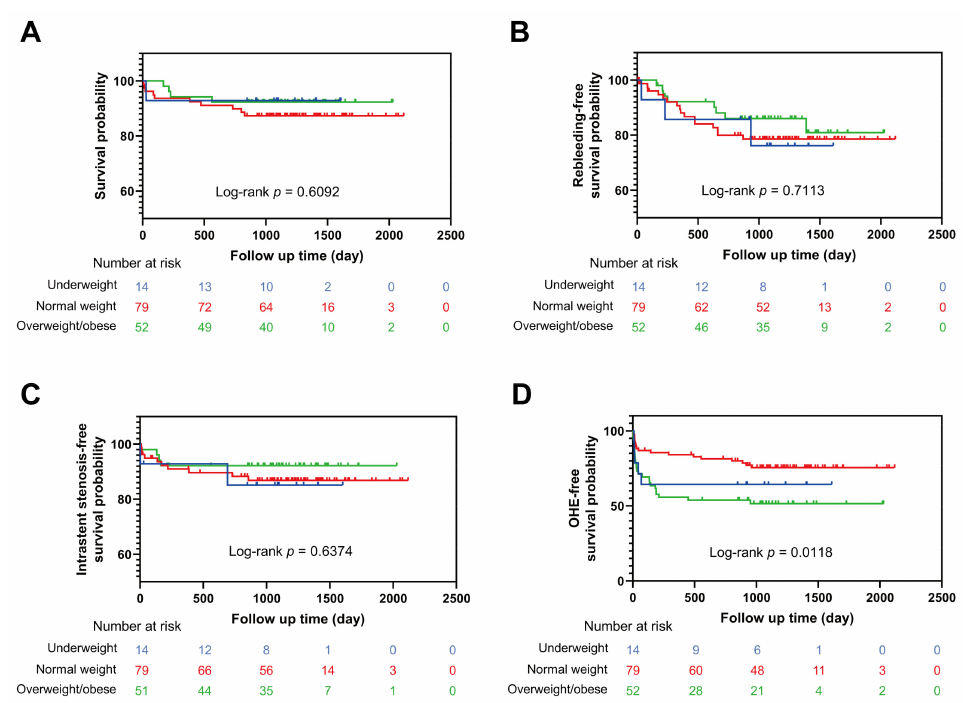
Figure 2. Outcomes after TIPS in patients via the Kaplan–Meier method. ( A ) The cumulative survival probability among the normal weight group, underweight group, and overweight/obese group. ( B ) The cumulative rebleeding-free survival probability among the three groups. ( C ) The cumulative intrastent stenosis-free survival probability among the three groups. ( D ) The cumulative OHE-free survival probability among the three groups. OHE, overt hepatic